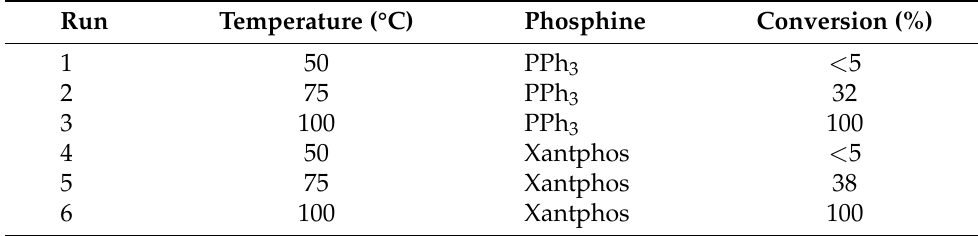
Table 1. Effect of temperature on conversion. The reactions were carried out at atmospheric pressure; the reaction time was 24